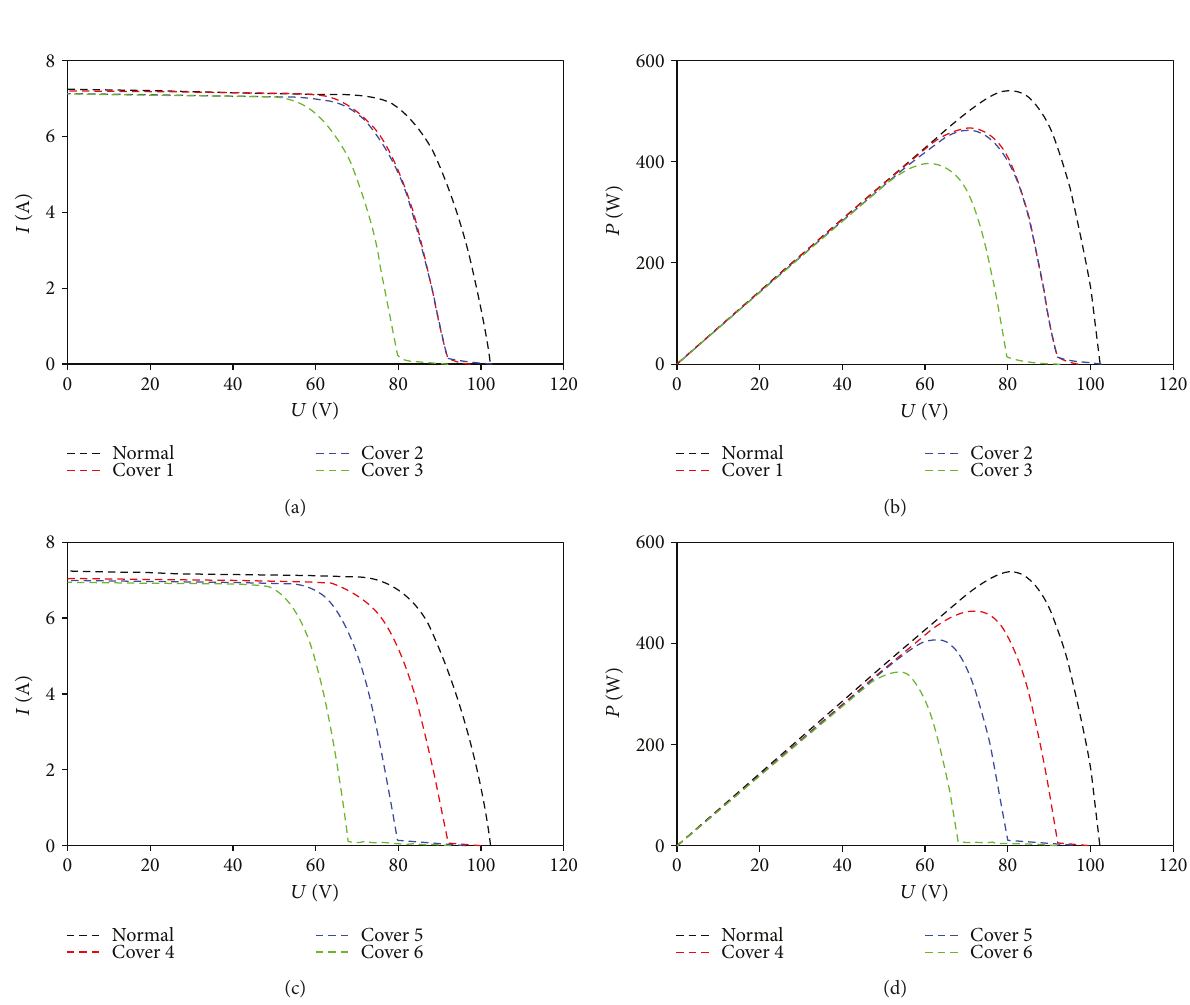
Figure 13: Results for the cover shading experiment. The curves are coincide with the simulation results.